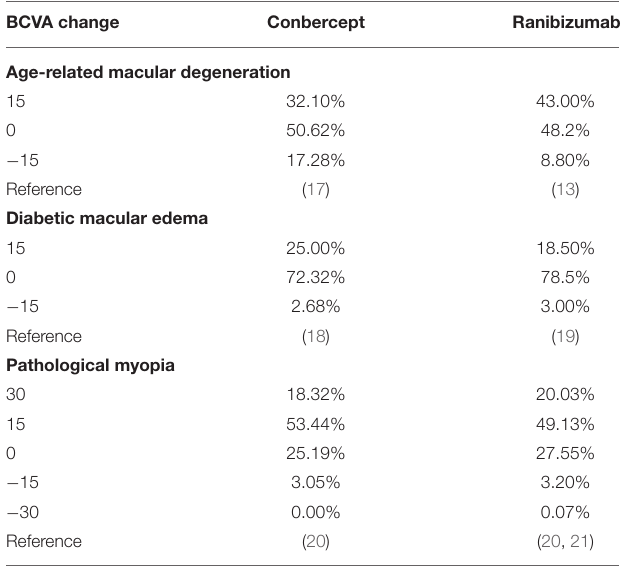
TABLE 2 | Best corrected visual acuity (BCVA) transition probabilities in 0–12 months.